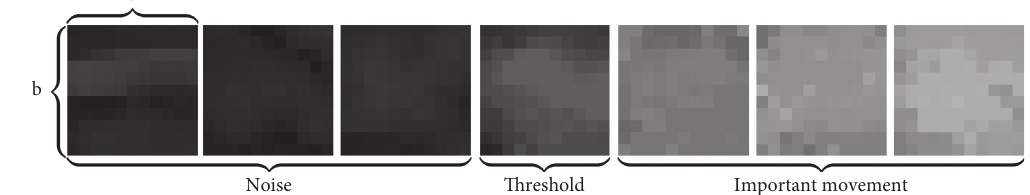
Figure 7: Example of bloc classification according to a noise model. The central bloc is the threshold. The blocs in the left are classified as noise. The blocs in the right are classified as an important movement that will be analyzed to determine its nature (swimmer or not). Swimming Championships in Limoges, France, April 2015.